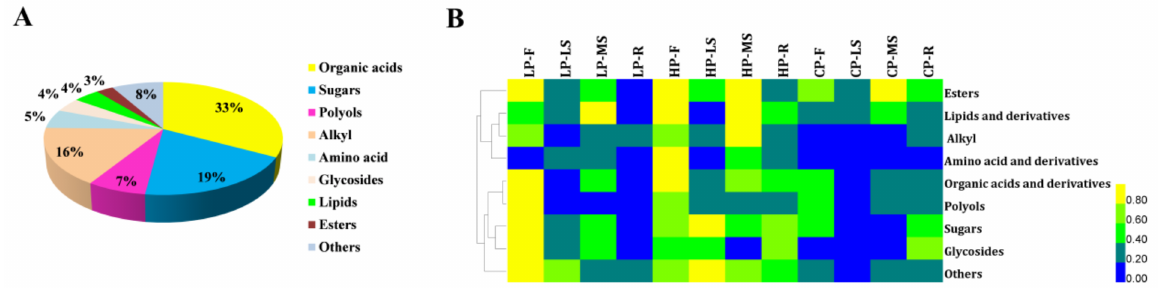
Figure 4. ( A ) Classification of 73 metabolites of Bupleurum . ( B ) The cluster analysis and heat map for Bupleurum plant parts under different levels of phosphorus fertilization. CP: control phosphorus; LP: low phosphorus; HP: high phosphorus; R: root; MS: main shoots; LS: lateral shoots; F: flower. The down-regulated and up-regulated and metabolites are represented as blue and yellow, respectively. The blue color means that abundance is 0, as shown in the lower right